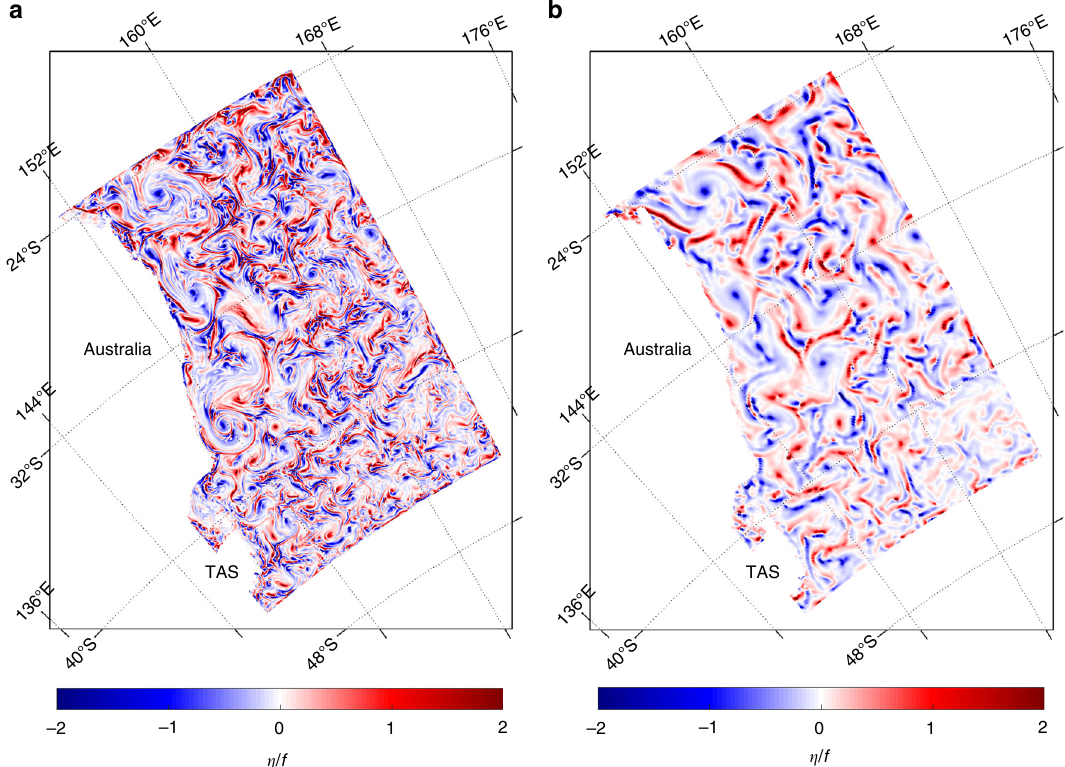
Fig. 1 Comparison of resolution in the reanalysis systems on 11 April 2006. The metric shown is relative vorticity normalised by planetary vorticity ( η / f ). a 2.5 km resolution system and ( b ) 10 km resolution system. Tasmania